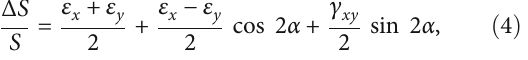
Figure 6: The raw data, annual periodic variation, and the long-term trend of over more than one year for (a) d 2016/01/01 to